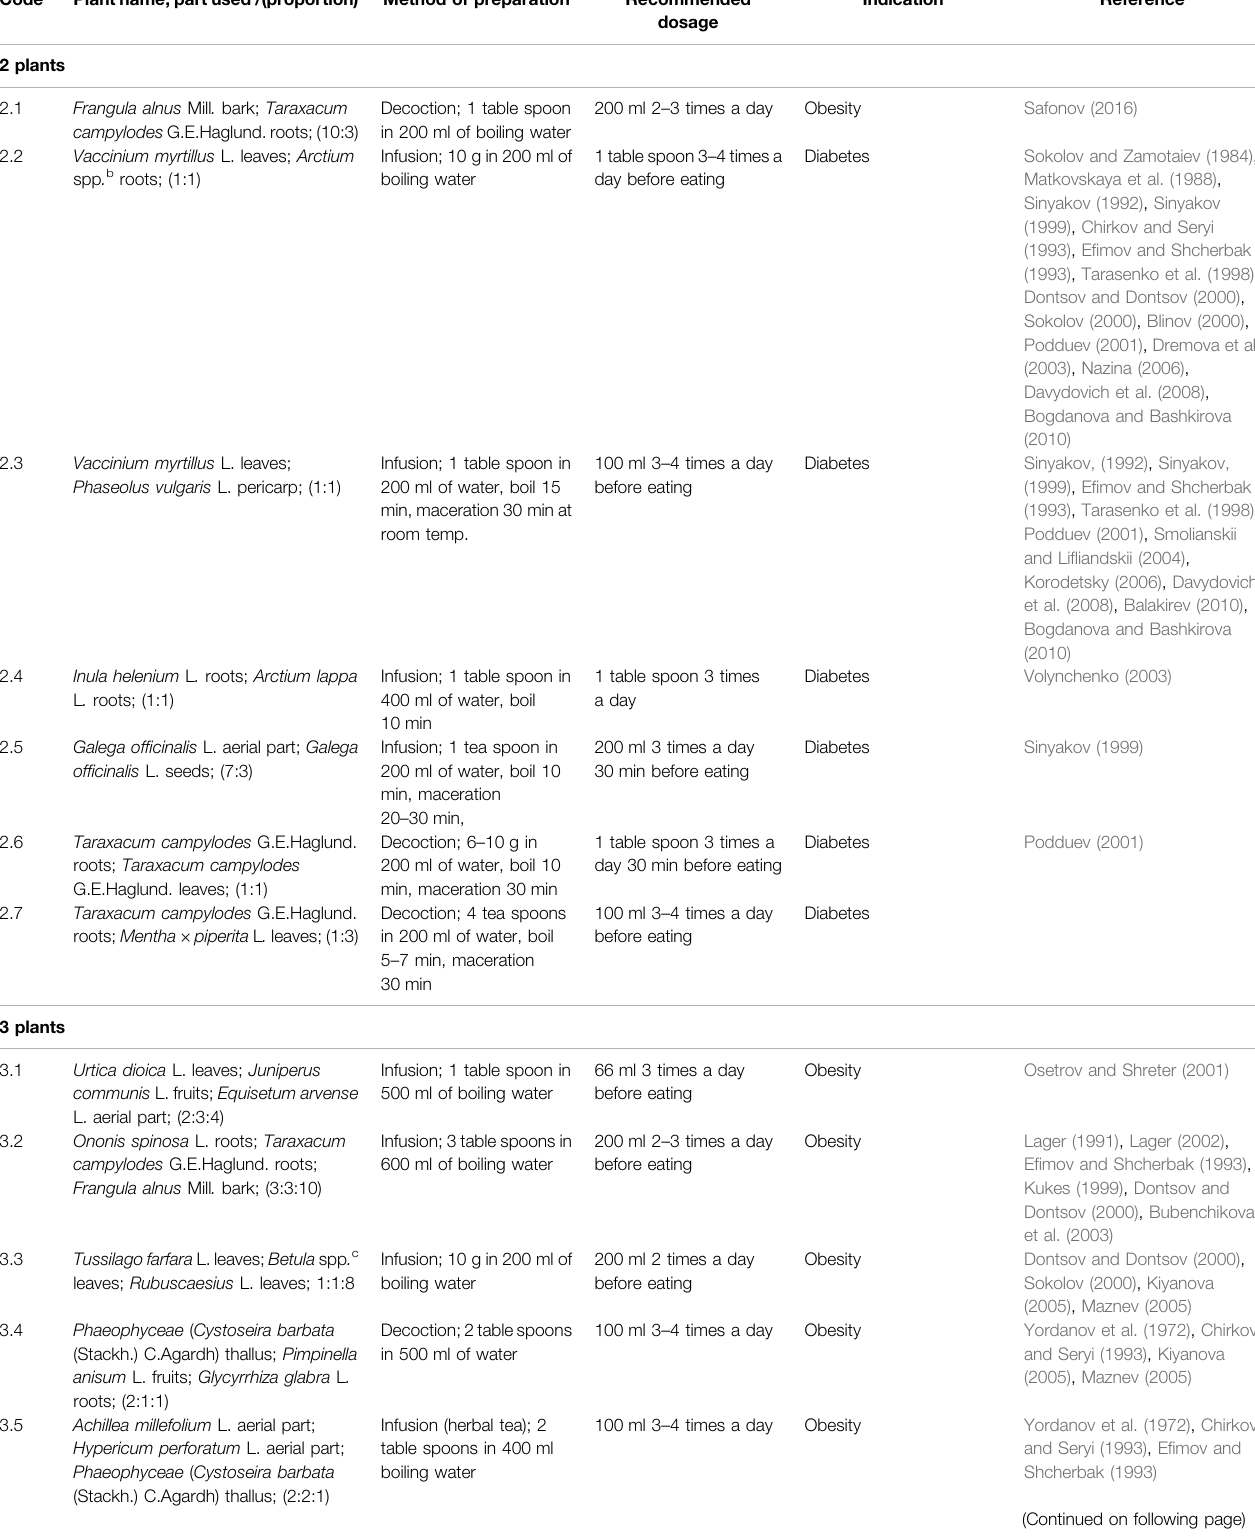
TABLE 1 | The list of medical species used for the management of diabetes and related disorders in Russia. Code a Plant name, part used /(proportion) Method of